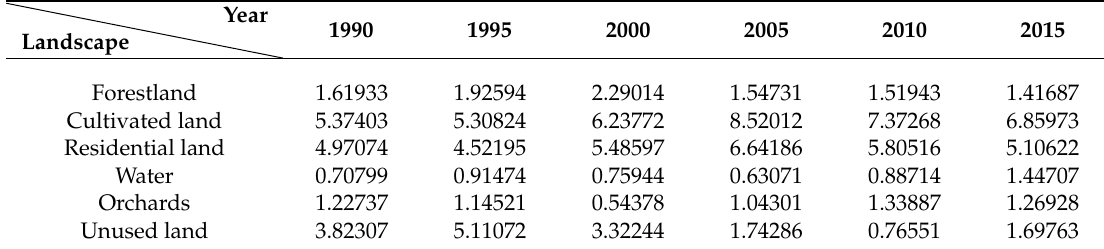
Table 14. Patch density (PD) for various types of landscape.